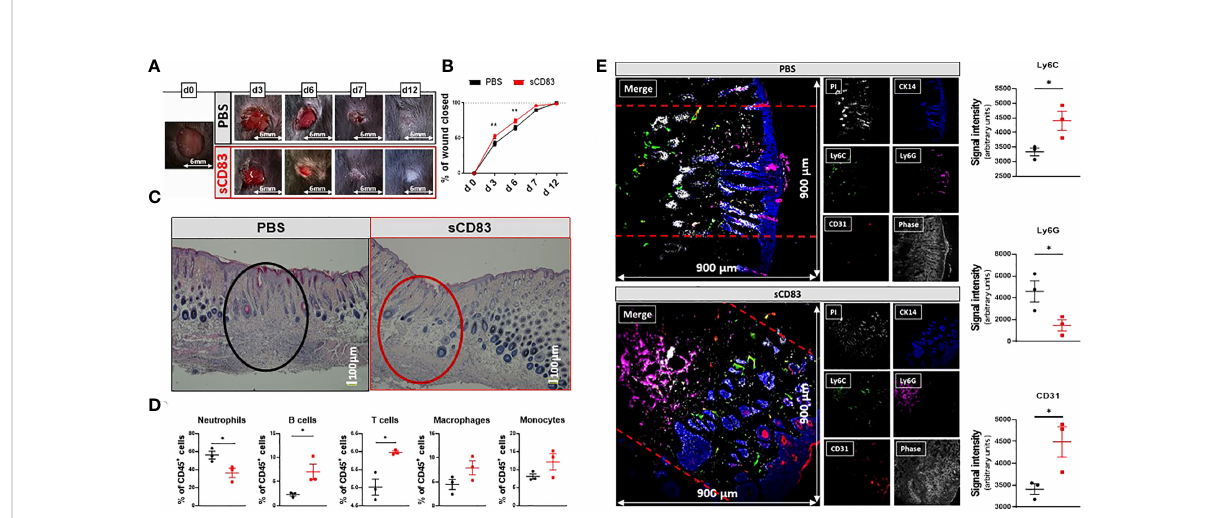
FIGURE 1 sCD83-treatment accelerates wound healing and modulates cellular composition within the wound beds. Wounds were in fl icted in anesthetized 7-weeks-old female C57BL/6 mice using a 6 mm biopsy punch. Administration of 100 µg sCD83 was performed systemically until day 7 on a daily basis. (A) Representative images of wound areas on day 0, 3, 6, 7, and 12. (B) Wound size was determined using caliper and expressed as percentage of wound closure relatively to the day 0 value (each group and time point n ≥ 12). (C) Representative H&E slides of day 7 wound biopsies. (D) Cellular composition within the wound biopsies of sCD83- and mock-treated mice, as assessed by fl ow cytometric analyses of day 6 samples (n=3). (E) Representative MELC-images (900µm x 900µm) of day 6 biopsy samples from PBS- and sCD83-treated mice [ (E) ; left-hand side] along with the corresponding quanti fi cation of signal intensity as determined using ImageJ with n=3 [ (E) ; right-hand side]. Dashed lines mark the wound site. Data are illustrated as mean ± SEM. Statistical analyses: (B) Two way ANOVA. Asterisks mark statistically signi fi cant difference (*p < 0.05 and **p < 0.01). The absence of asterisks indicates that there is no statistical signi fi